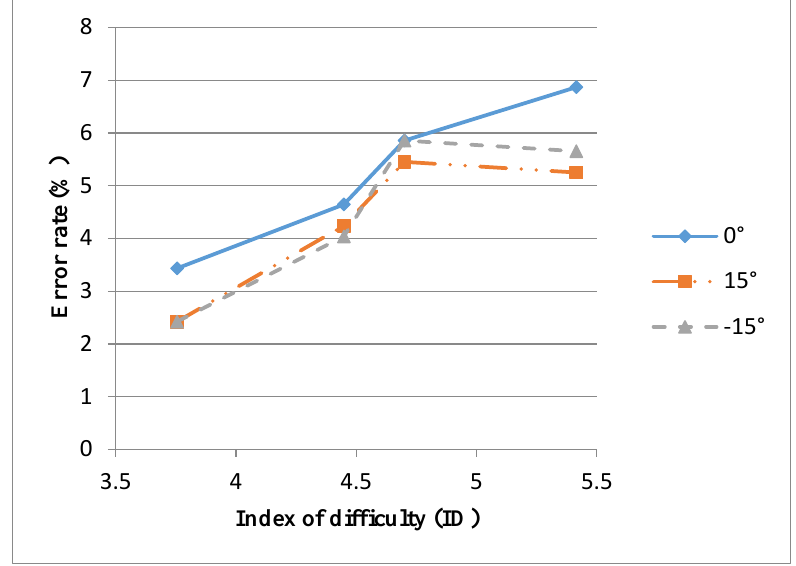
Figure 9. Error rate for the teach pen operation at different IDs and inclination